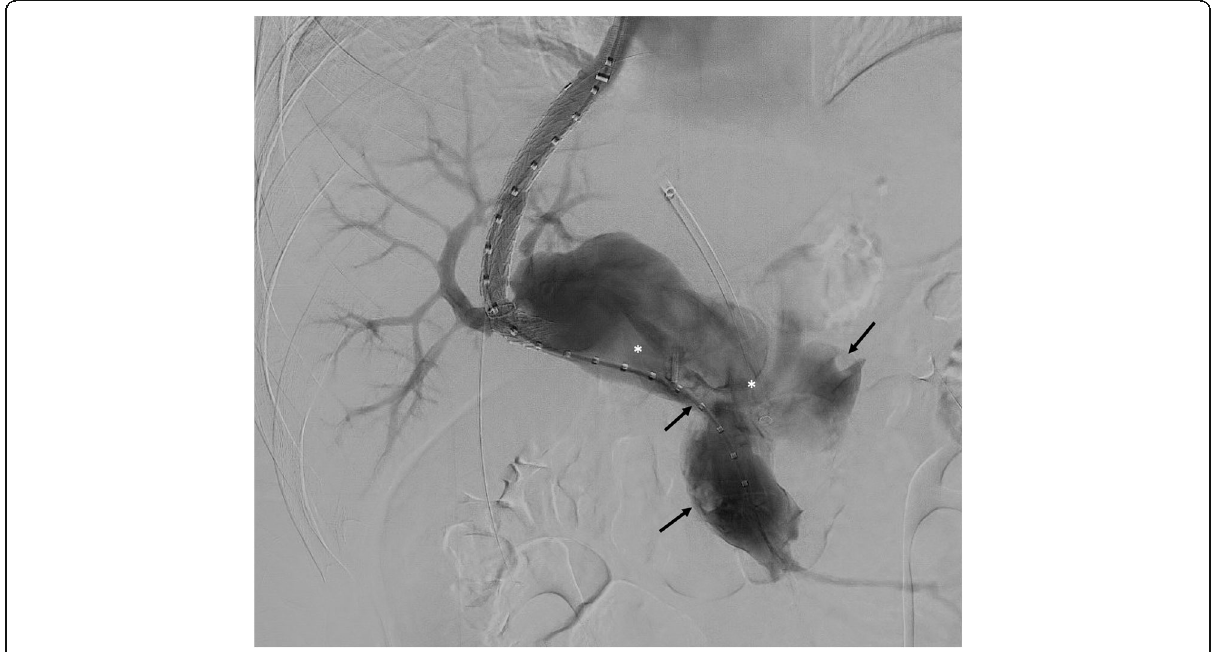
Fig. 3 Portomesenteric venography after TIPS placement and additional rheolytic thrombectomy. Minimal non-occlusive thrombus remains (arrows). Turbulent flow of contrast through the aneurysm is noted (*). The posterior right and segment IV portal vein branches are now patent. The transhepatic vascular sheath within the occluded left portal vein is also